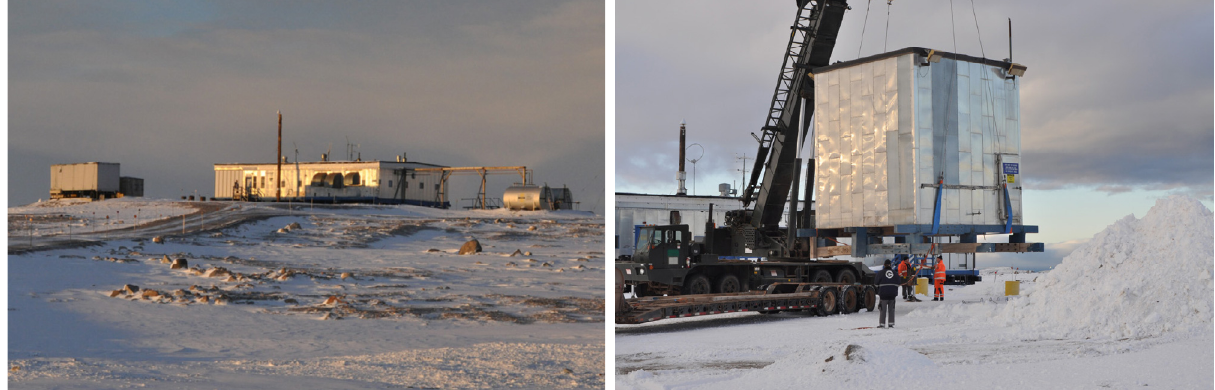
Figure 17. Building #1971 (left) and the DMI balloon house at its new location on South Mountain, next to building #1971